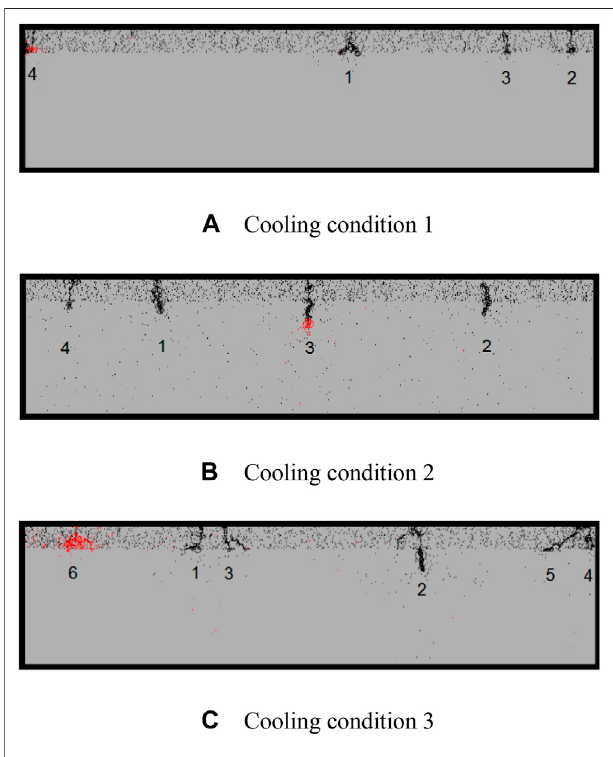
FIGURE 4 | Final failure patterns of three cooling conditions. (A) Cooling condition 1, (B) Cooling condition 2, and (C) Cooling condition 3.